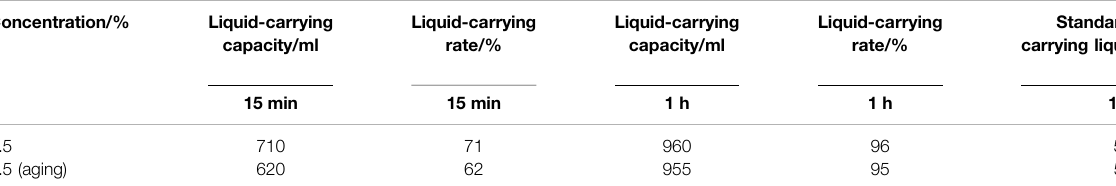
TABLE 4 | Comparison of liquid-carrying capacity of AES at room temperature and high temperature at 0.5% concentration.